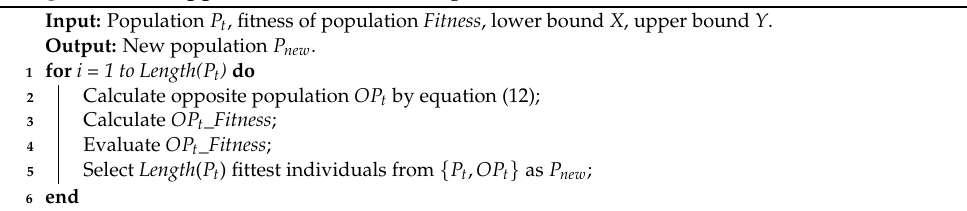
Algorithm 2: Opposition-based